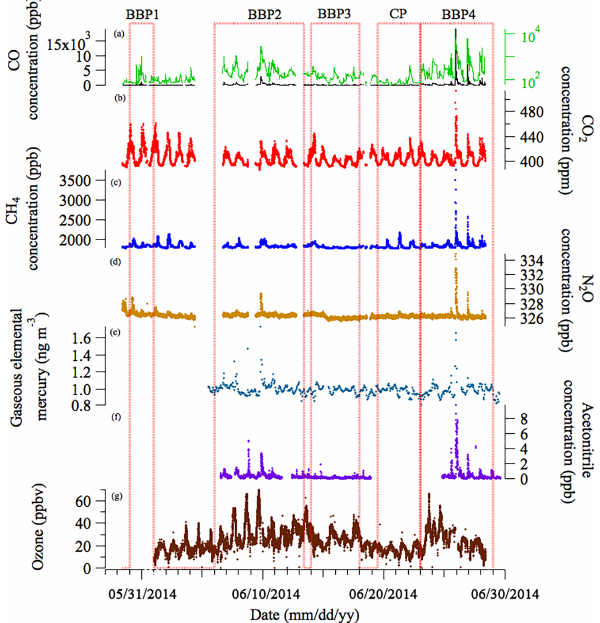
Figure 3. The time series of the major measured gaseous species during the SAFIRED campaign: (a) carbon monoxide, (b) carbon dioxide, (c) methane, (d) nitrous oxide, (e) gaseous elemental mer- cury, (f) acetonitrile and (g) ozone. The biomass burning and coastal periods are indicated by the red dotted lines. All parts-per notation refers to mole fractions unless otherwise indicated. The date and time is local